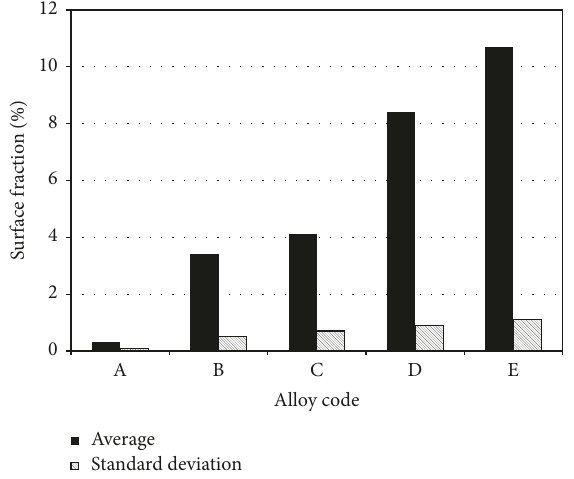
Figure 4: Surface fraction of the Mg-Al-Zn phase in the present alloys based on 20 fields/alloy at